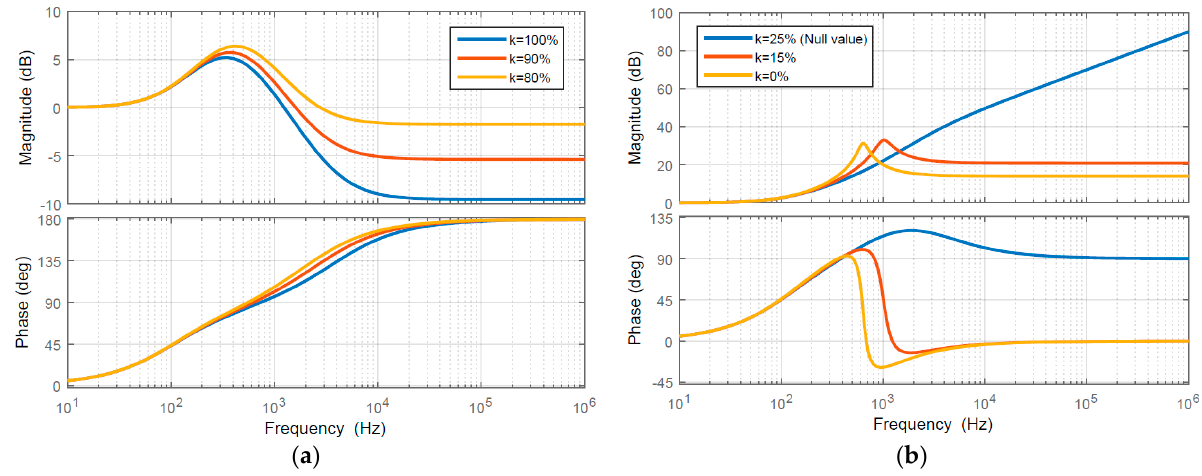
Figure 4. Y-source current frequency response ( a ) k is larger than k null and ( b ) k is smaller than k null . Table 2. Parameter values of the proposed Y-source circuit breaker.